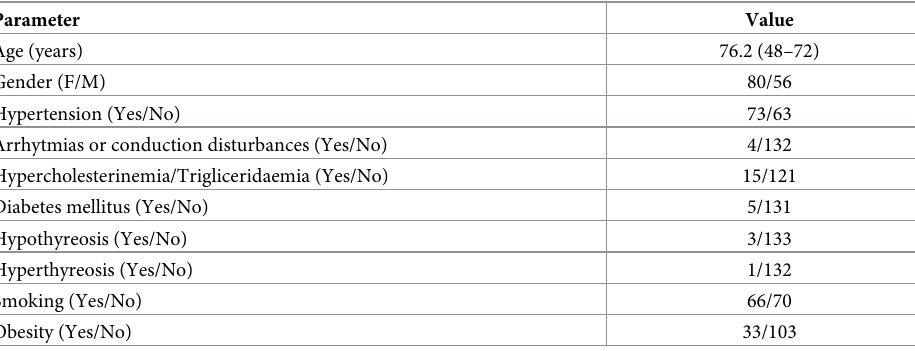
Table 1. General characteristics and confounding factors in the entire